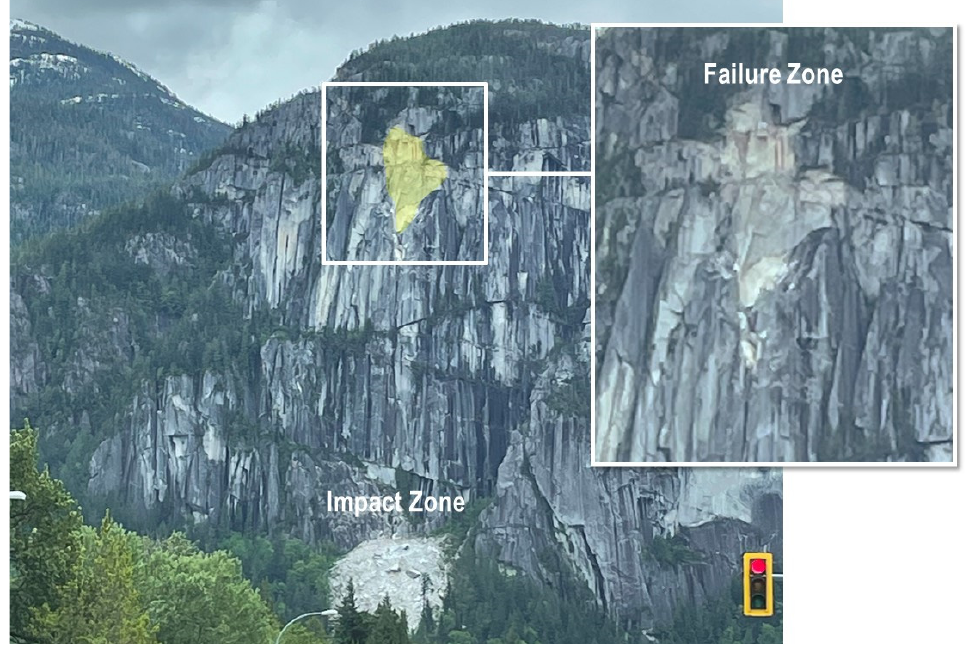
Figure 2. Example of failure of sheeting joint structures on steep slopes (Squamish, Canada).